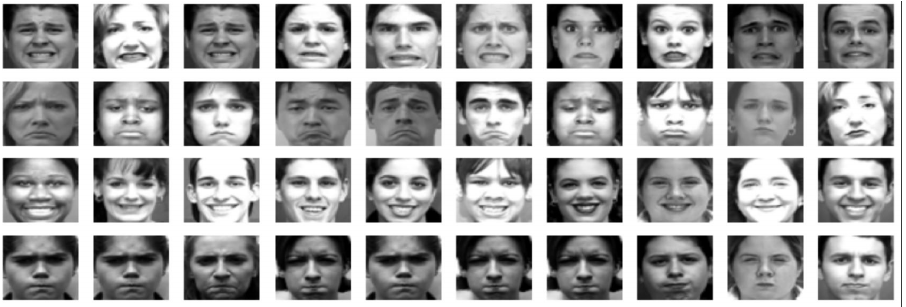
Figure 3. Samples from the CK+48 dataset.